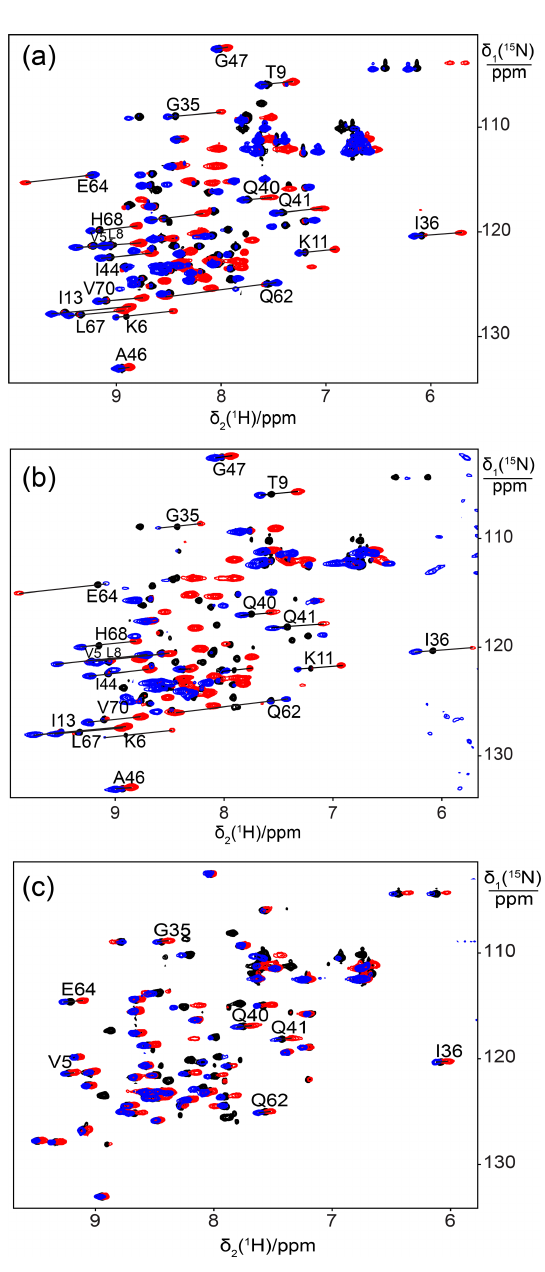
Figure 1. Superimposition of [ 15 N, 1 H]-HSQC spectra of 0.5mM solutions of 15 N-labelled ubiquitin mutated to generate a lanthanide-binding site at residue 18. Spectra with diamagnetic Y 3 + are plotted in black and with paramagnetic Tb 3 + and Tm 3 + in red and blue, respectively. Lines were drawn to connect some of the cross-peaks belonging to the same residue in the paramag- netic and diamagnetic samples and are labelled with the residue name and sequence number. (a) Mutant E18Sep. (b) E16Q/E18Sep. (c) E18Sep/D21N.